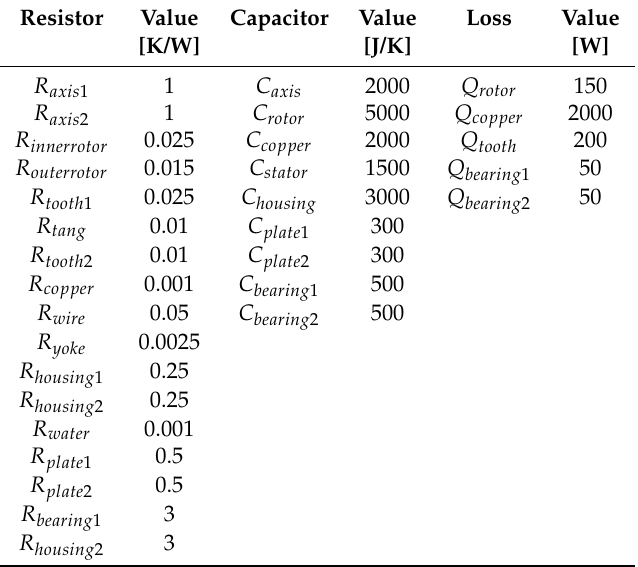
Table 2. Parameters of the thermal model of the synchronous motor.